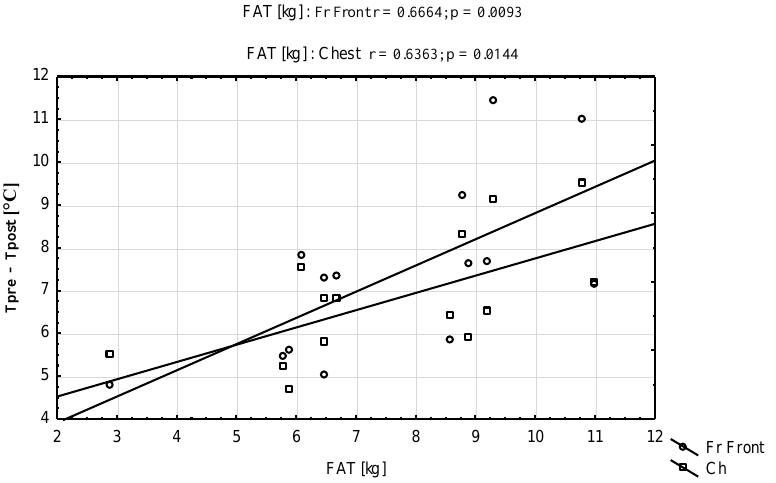
Figure 6. Relationship between body fat and the magnitude of change in temperature of the forearm front and chest. Legend: Fr — forearm; Ch — chest.